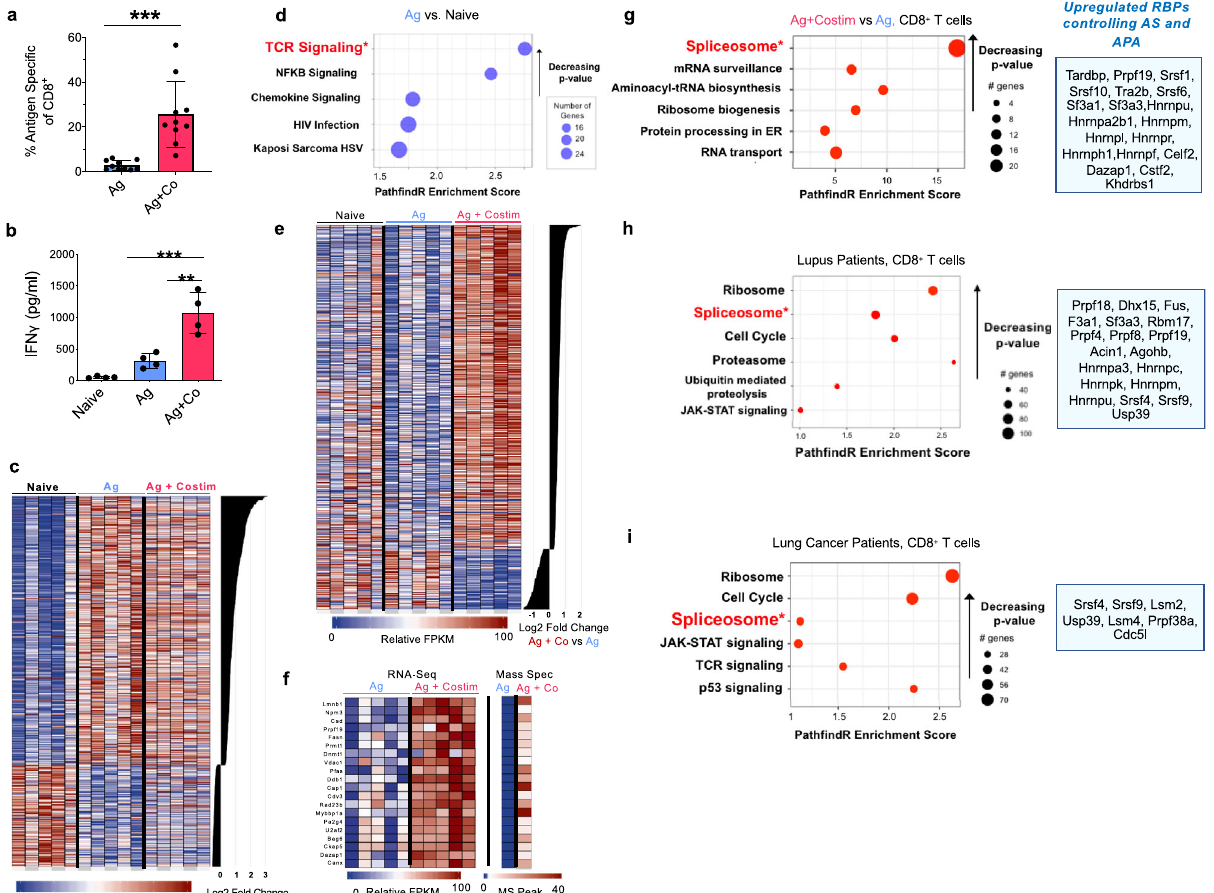
Fig. 1 Costimulation of CD8 + T cells upregulates a unique genetic signature of RNA binding proteins critical for alternative RNA splicing and alternative polyadenylation. a Percent OT-I, CD45.1 + cells of CD8 + T cell from spleen and lymph nodes 3.5 days after receiving antigen alone or antigen with costimulation as described in Supplementary Fig. 1. Data were pooled from two independent experiments. Each data point represents a biological replicate, n = 10. b ELISA for IFN γ secretion after restimulation of sorted, puri fi ed OT-I cells with PMAi for 20 h n = 4/group. Data is representative of 1 of 2 independent experiments. c . Relative FPKM levels of the top700 genes ranked by log 2 fold change between antigen and naïve groups (FDR < 0.05), n = 5/ group. Data is representative of 1 of 2 independent experiments where each column represents an individual biological replicate. d Pathway analysis of 700 genes identi fi ed in 1c ranked by log 2 fold change between Ag alone and Naïve (blue) ( e ) Relative FPKM levels of 700 genes ranked by log 2 fold change (FDR < 0.05) between Ag + Costim and Ag alone groups, n = 5/group. Data is representative of 1 of 2 independent experiments where each column represents an individual biological replicate. f Top 20 (of 274) genes found to be signi fi cantly upregulated expressed between Ag + Costim and Ag alone groups in both RNA & mass spectrometry experiments (FDR < 0.05), n = 5/group. g Pathway analysis of 274 genes identi fi ed in d ranked by log 2 fold change between Ag + Costim and Ag alone groups. The blue panel shows 19 upregulated RBPs regulating AS and APA out of 118 genes and proteins found upregulated across 2 datasets (Supplementary Fig. 1) between Ag + Costim and Ag alone groups, n = 10/group across 2 datasets for RNA, n = 2 pooled from 10 samples across 2 datasets for mass spectrometry. h Pathway analysis of genes identi fi ed as signi fi cantly differentially expressed (FDR < 0.05) in CD8 + T cells from blood of lupus patients compared to healthy controls and 19 RBPs upregulated between these groups, n > 14/group. i Pathway analysis of genes identi fi ed as signi fi cantly differentially expressed (FDR < 0.05) in intratumoral PD1 + CD8 + T cells patients compared to intratumoral PD1 − CD8 + T cells and 7 RBPs upregulated between these groups, n = 11/group. Data are presented as mean values + / − SD using a two-sided t test with Benjimini, Krieger, and Yekutieli to control FDR where * represents n digits after decimal for p value. Source data are provided as a Source Data fi